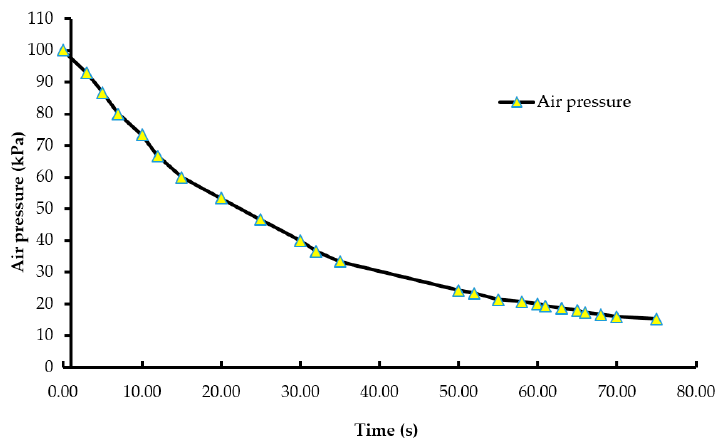
Figure 3. Pressure wash-out curve (pressure vs. time). The air pressure of the chamber was decreased from 100.12 kPa to 15.3 kPa during the LAPS treatment. The custom-built vacuum system was equipped with a vacuum controller, which measured and maintained negative air pressure within the chamber.